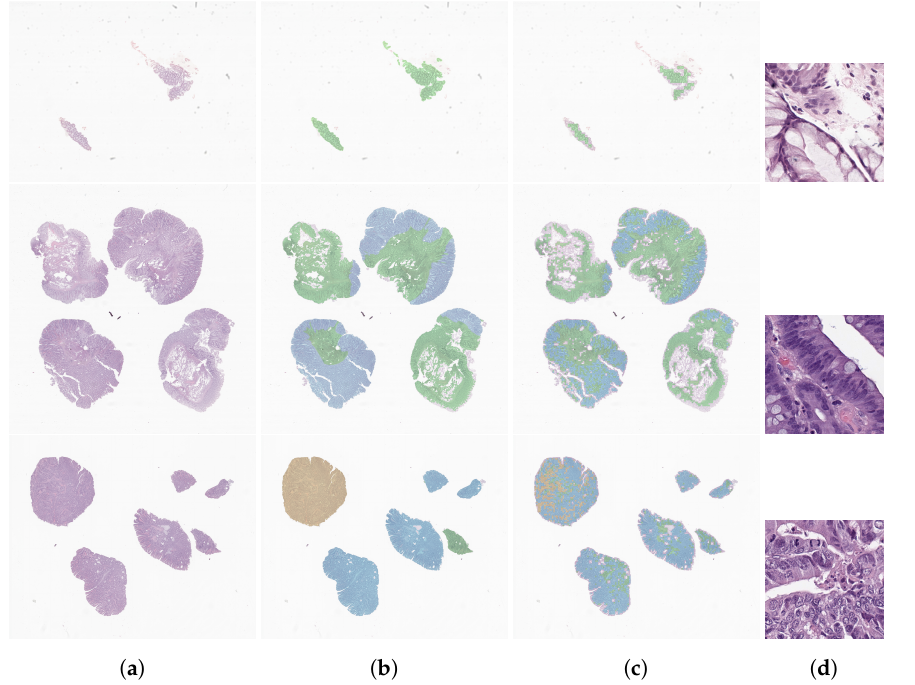
Figure 6. Examples of a model prediction map for each class, from the annotated data subset: a non- neoplastic case ( top ), a low-grade lesion ( middle ) and a high-grade lesion ( bottom ). Each column has the slides examples ( a ), the ground-truth annotation ( b ), the map with the tile predictions ( c ) and the most relevant tile (512 × 512 px), with the worst clinical class ( d ). The non-neoplastic, low-grade and high-grade regions are represented in green, blue and yellow, respectively.